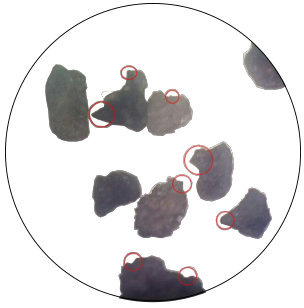
Figure 9. Shape of sediments found in Pastaza River.